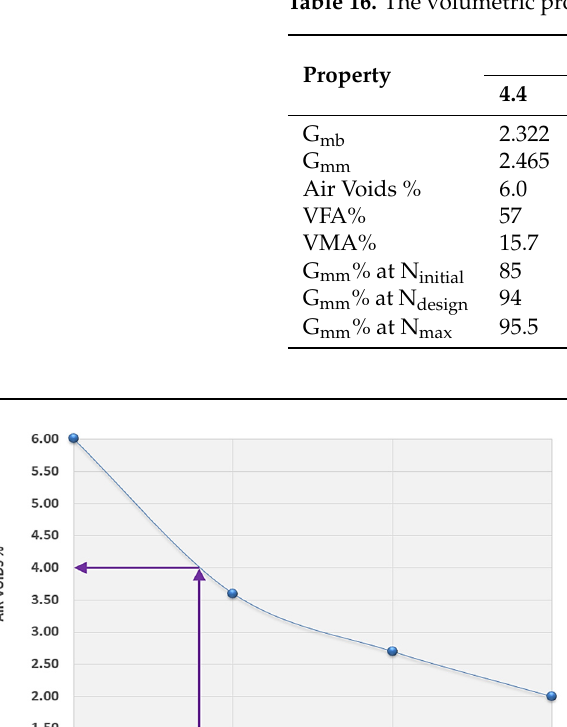
Table 16. The volumetric properties of the trial mixtures.